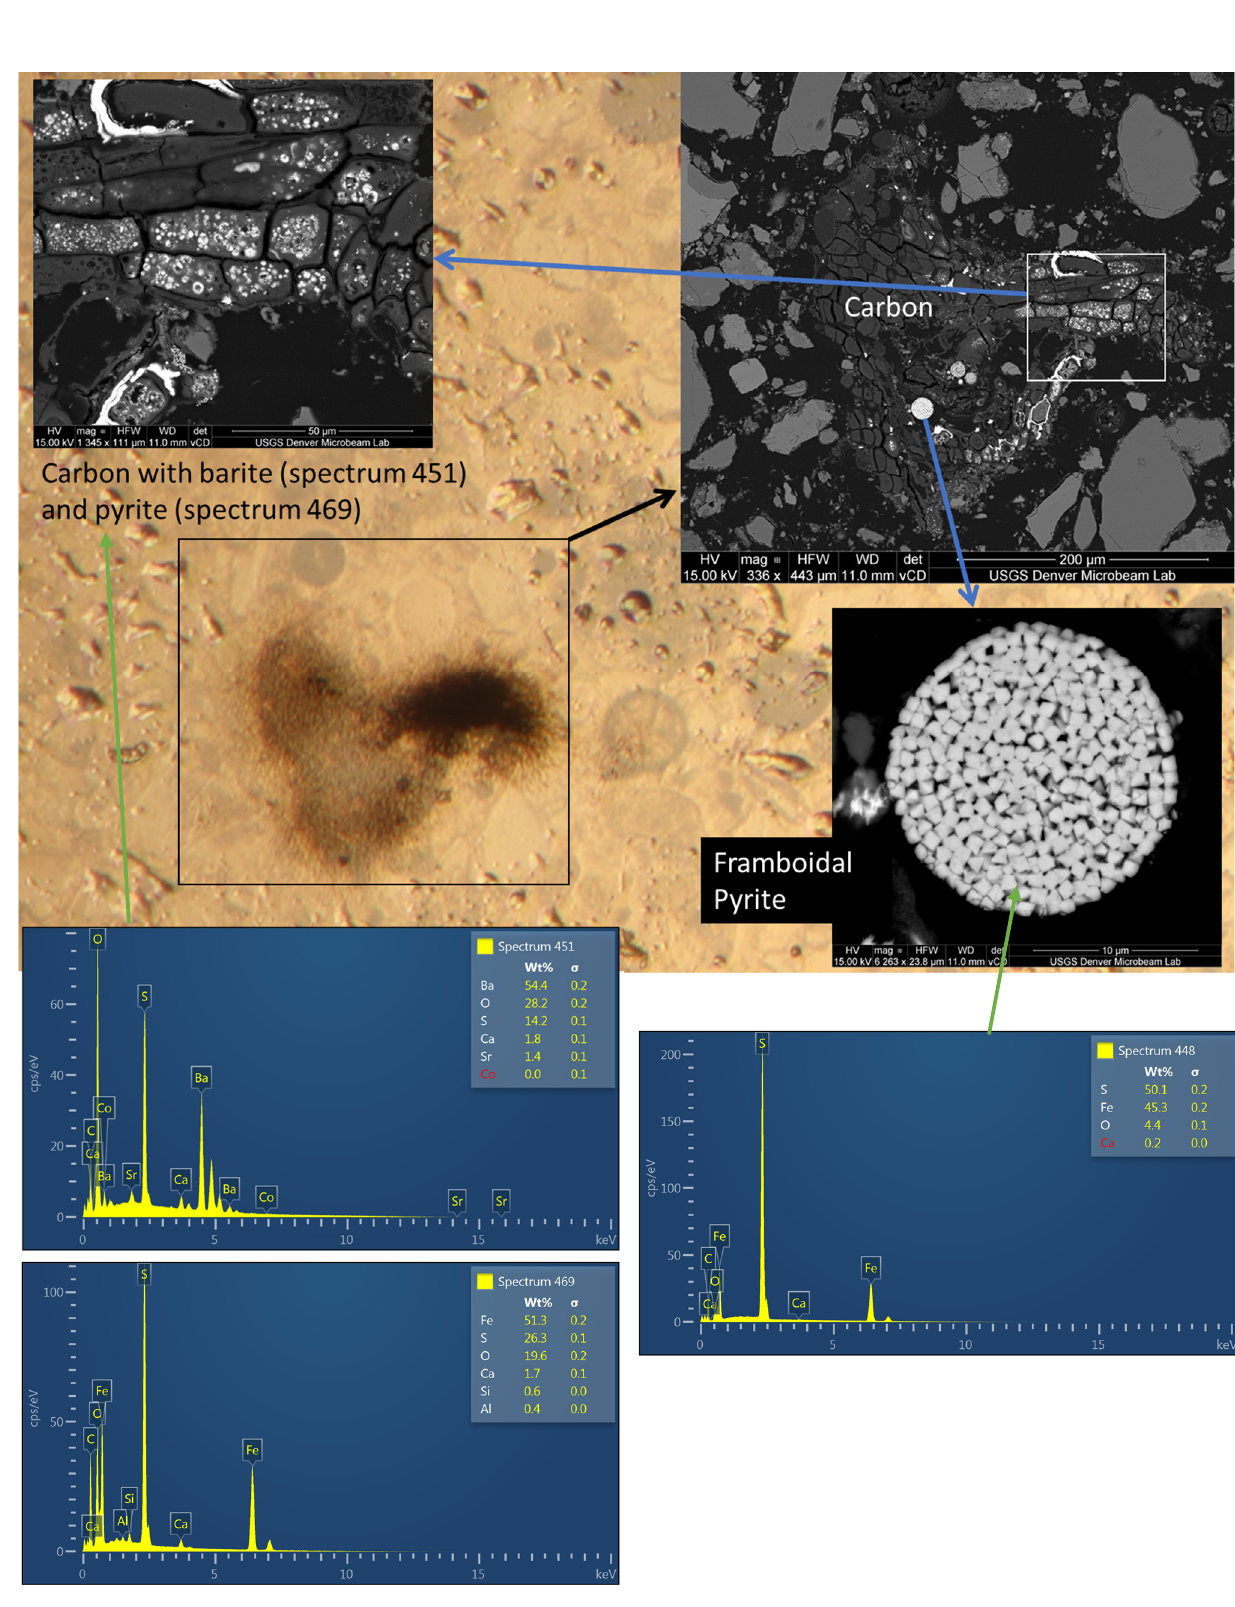
Figure 18. GJAST-15-13 area 7 (Figure 9), thin section plain light background with fission-track overlay at 25% transparency with added SEM-BSE images and EDS spectrums. Bright white streaks are barite.